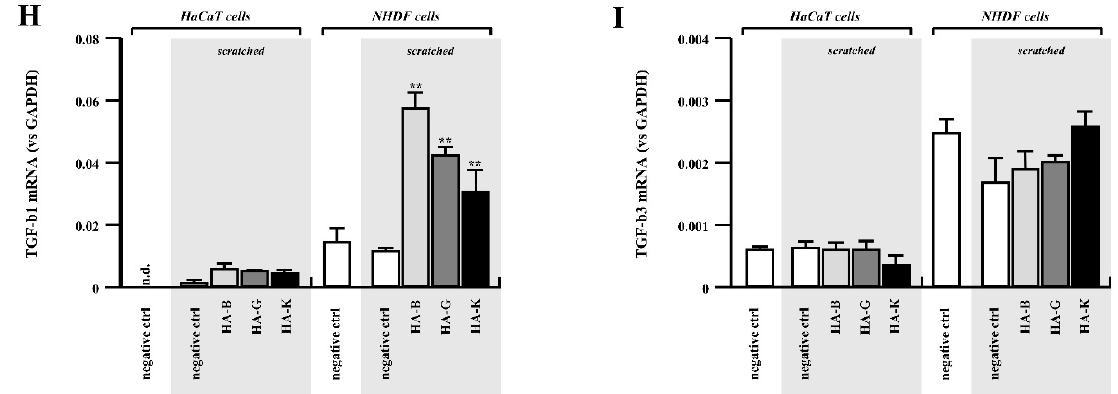
Figure 9. Gene expression induced by HA administration in HaCaT and NHDF cells. Gene expression of IL-1 β ( A ), IL-6 ( B ), IL-8 ( C ), VEGF ( D ), MMP-2 ( E ), MMP-9 ( F ), MMP-13 ( G ), TGF- β 1 ( H ) and TGF-3 β ( I ). Results from HaCaT cells are shown on the left side and from NHDF cells are on the right side. Relative gene expression level (vs GAPDH) from scratched cells is shown on grey background. Relative mRNA expression of cells with 0% HA is filled in white bar, 0.1% HA-B is in light grey, 0.1% HA-G is in grey and 0.1% HA-K is in black bar. Data are expressed as mean ± SEM. * p < 0.05 vs unscratched control group (** p < 0.05 vs. 0% HA control group, n = 5).